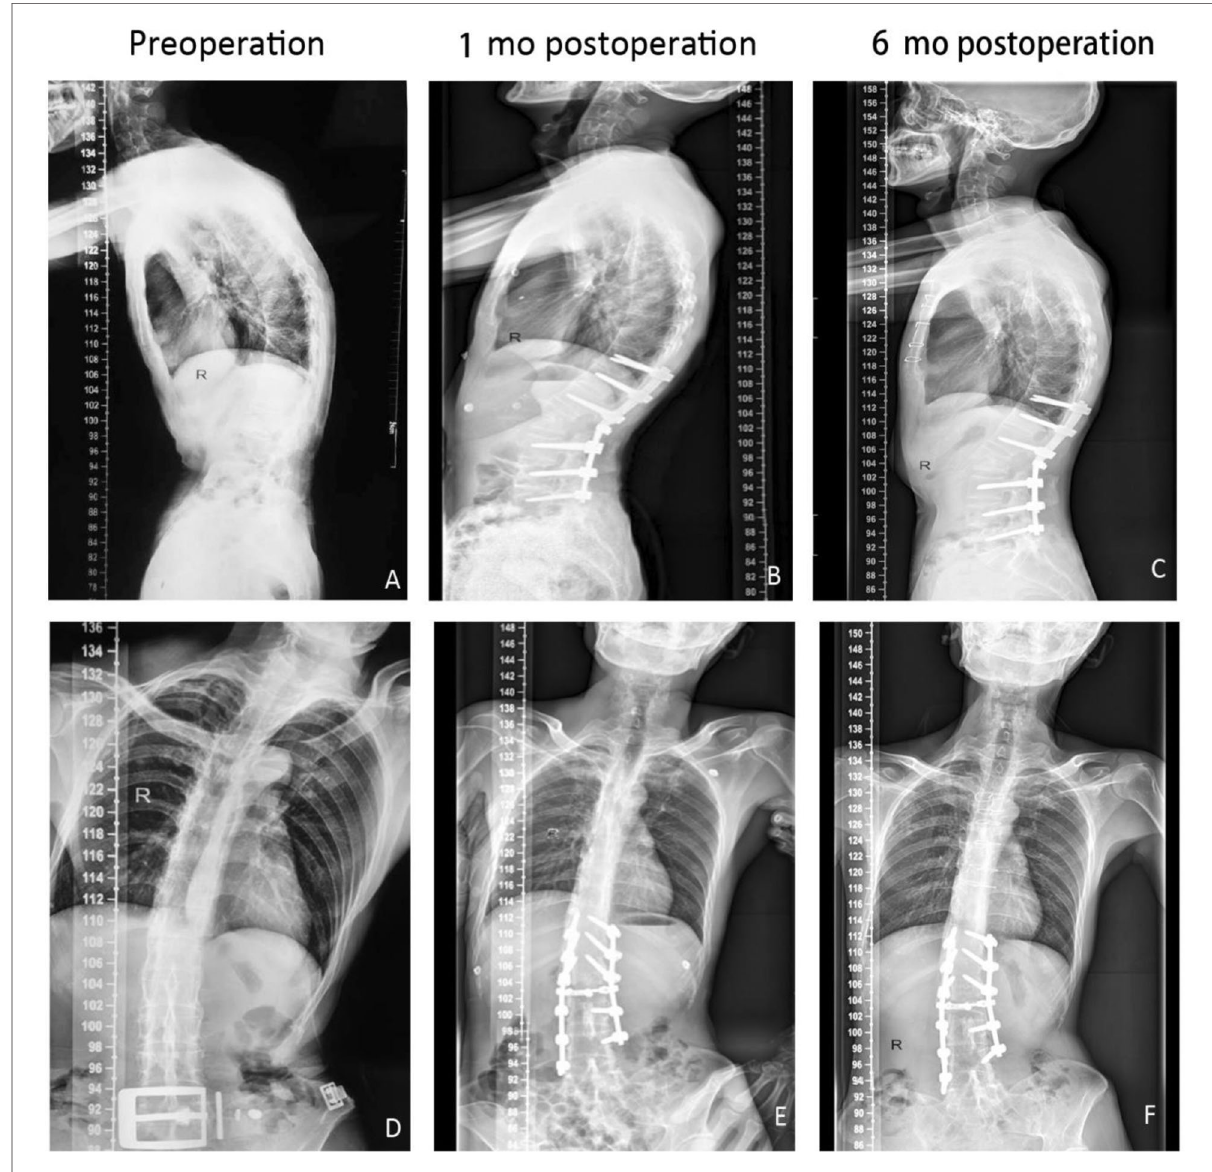
FIGURE 1 Male, aged 40, ankylosing spondylitis with kyphosis, preoperative whole spine lateral radiographs showed thoracolumbar kyphosis, spine sagittal imbalance ( A ), cobb angle 40° ( D ). The spine sagittal rebalanced ( B,C ) and the Cobb angle corrected to 20° ( E,F ), tested 1 month and 6 months after operation,